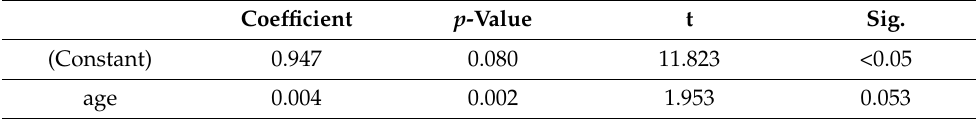
Table 4. Regression model of reaction